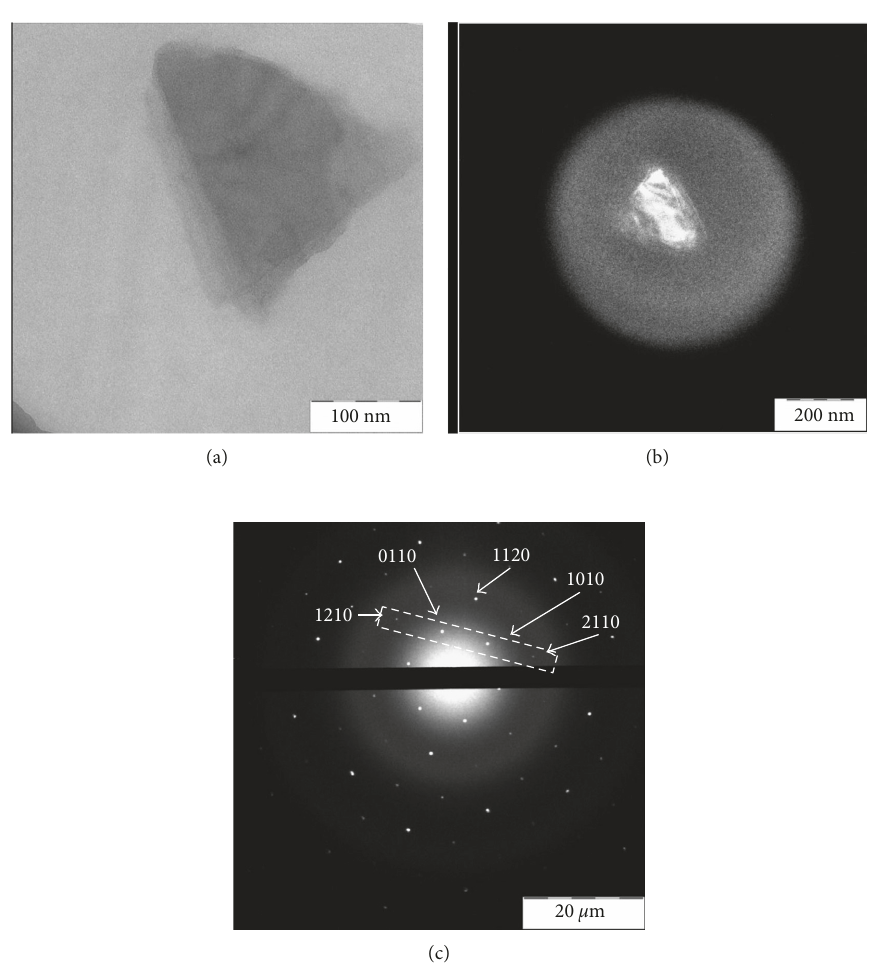
Figure 7: TEM images of graphene clusters from the Gr diffraction